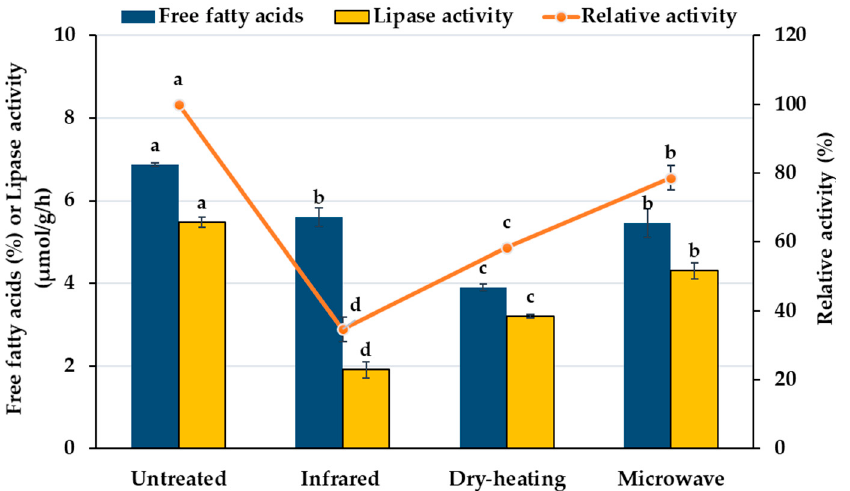
Figure 1. Effect of three different heating treatments (infrared-radiation, dry-heating, and microwave-heating) on free fatty acids content and relative lipase activity of RB samples; values followed by the same letter for the same estimated parameter are not significantly different ( p > 0.05).